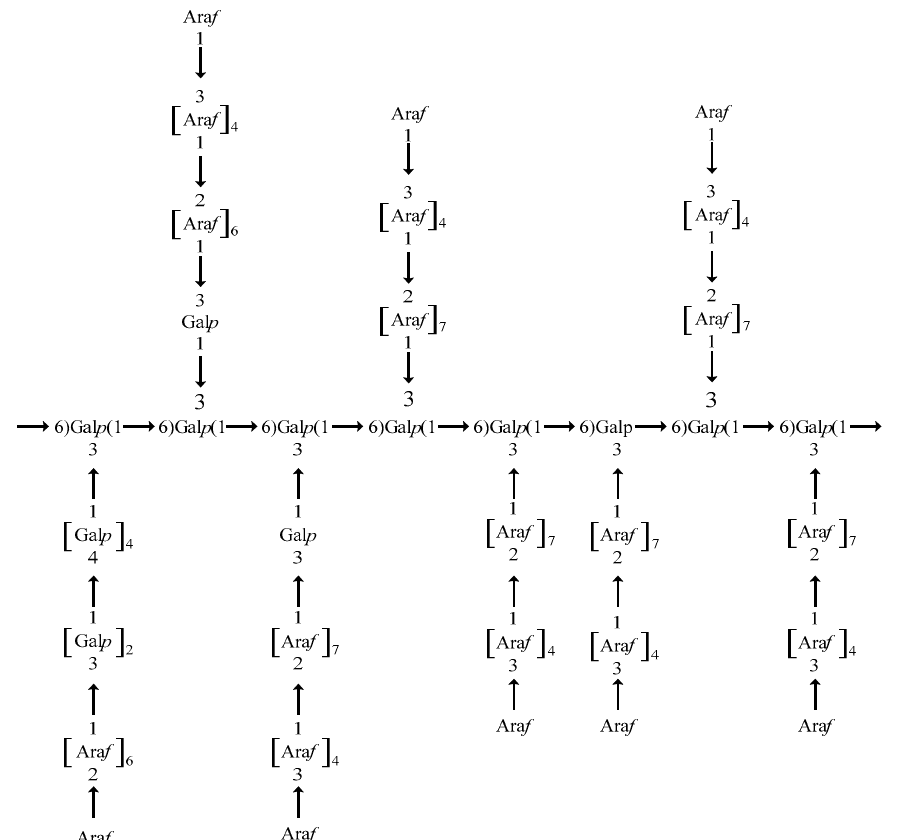
Figure 5. The hypothetical structure of the repeating unit of LbGp1.